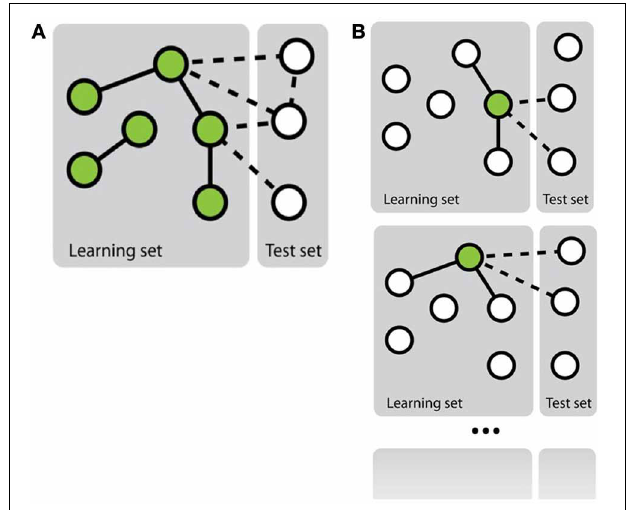
FIGURE 1 | Schematic representation of the two main approaches to solve the problem of network inference. (A) The global approach that solves a single supervised learning problem by considering each pair as an object for the learning. (B) The local approach that solves several supervised learning problems, each defined by a different